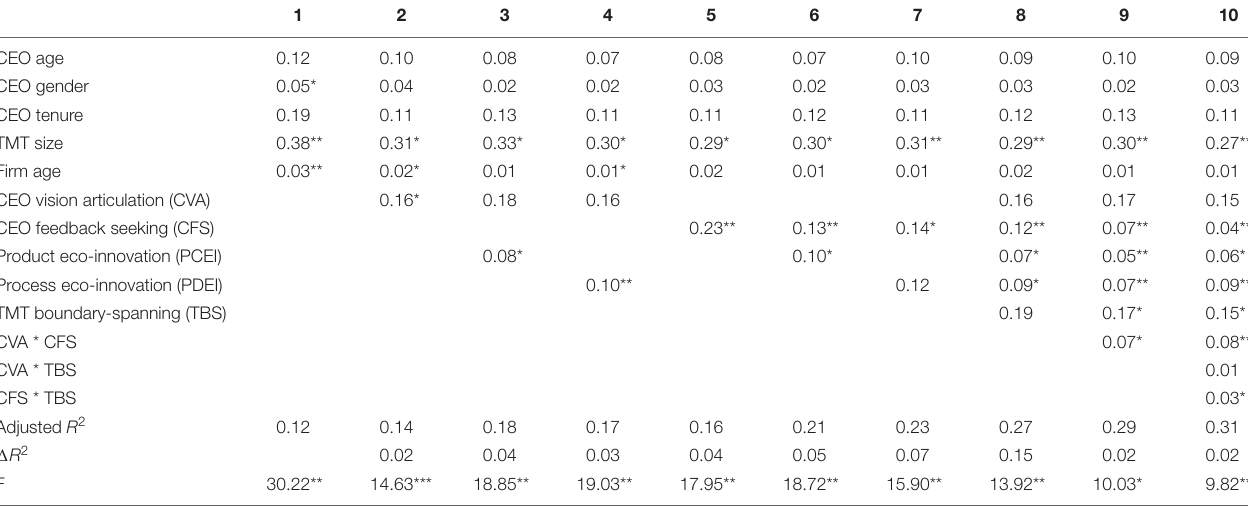
TABLE 2 | Hierarchical regressions on firm sustainability.